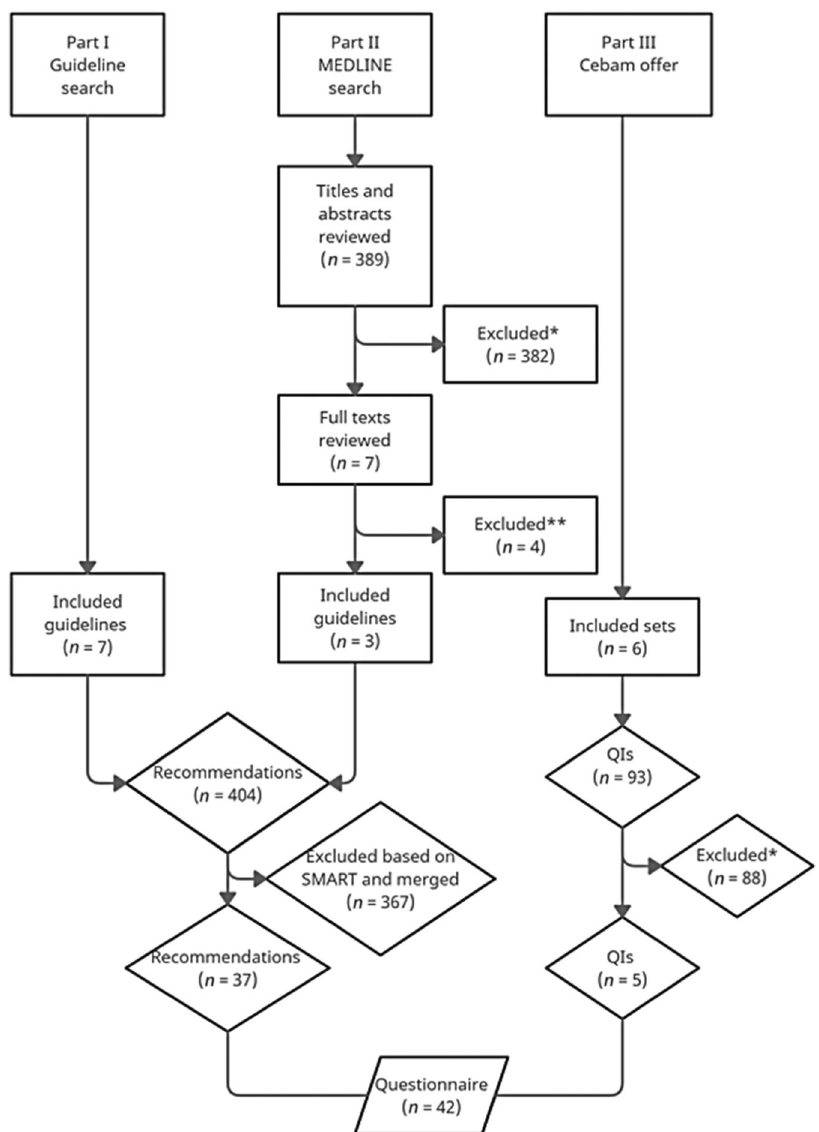
Fig. 1 Flowchart of selection of recommendations and QIs from evidence-based guidelines. *Titles, abstracts, and quality indicators excluded for one of the following reasons: published before 2012, no English or Dutch, no full text access, incorrect subject (e.g., lung cancer screening), incorrect target users (e.g., pulmonologists), no guidelines or duplicates. **Full texts excluded because three did not suf fi ciently meet quality criteria and one was a